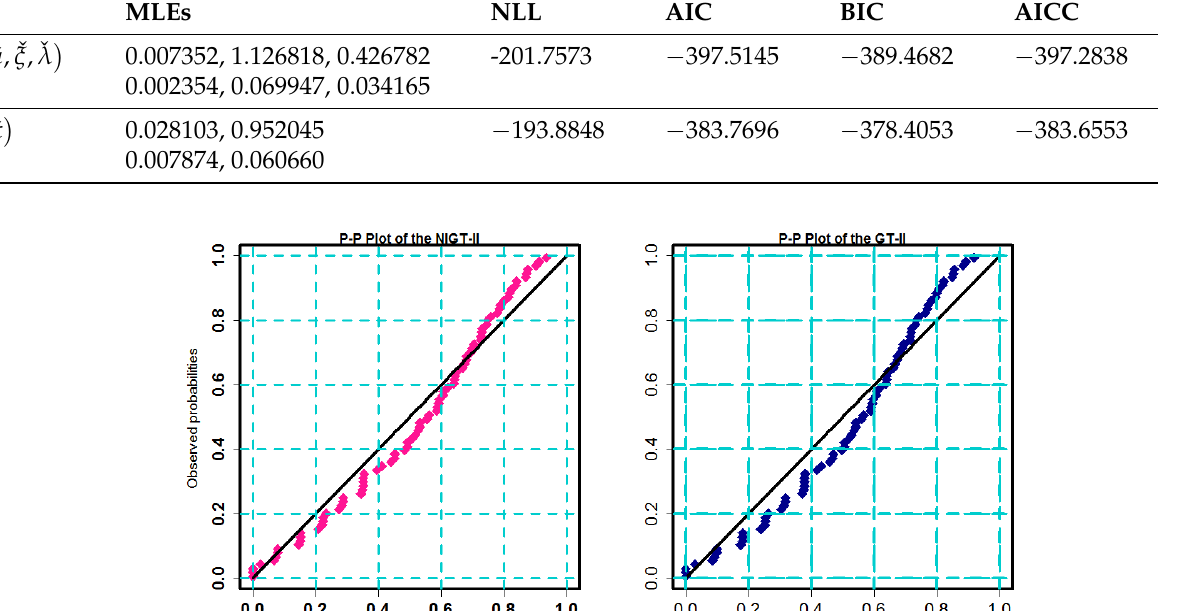
Fig. 7. Probability plots of NIGT-II and GT-II models for dataset I. Figure 7. Probability plots of NIGT-II and GT-II models for dataset